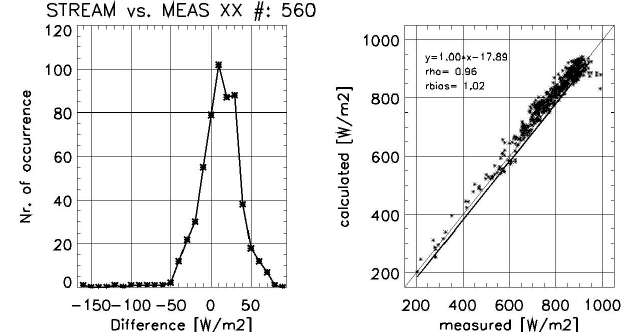
Figure 5. Systematic deviations of calculated and measured irra- diances averaged from 10:00–13:00UTC for pyranometer sites. A distinct peak can be found at positive di ff erences (measured sub- tracted from modeled).